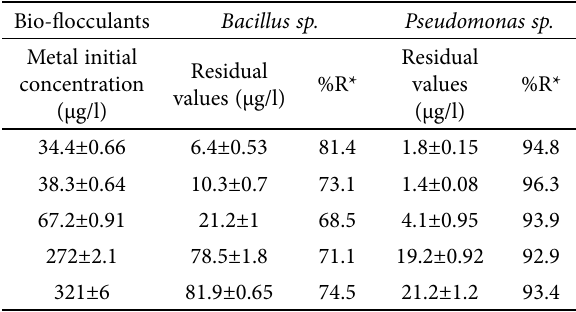
Table 3. The efficiency of bio-flocculants of Bacillus sp. versus Pseudomonas sp. for removal of Cadmium (Cd 2+ ) Bio-flocculants Bacillus sp. Pseudomonas sp.